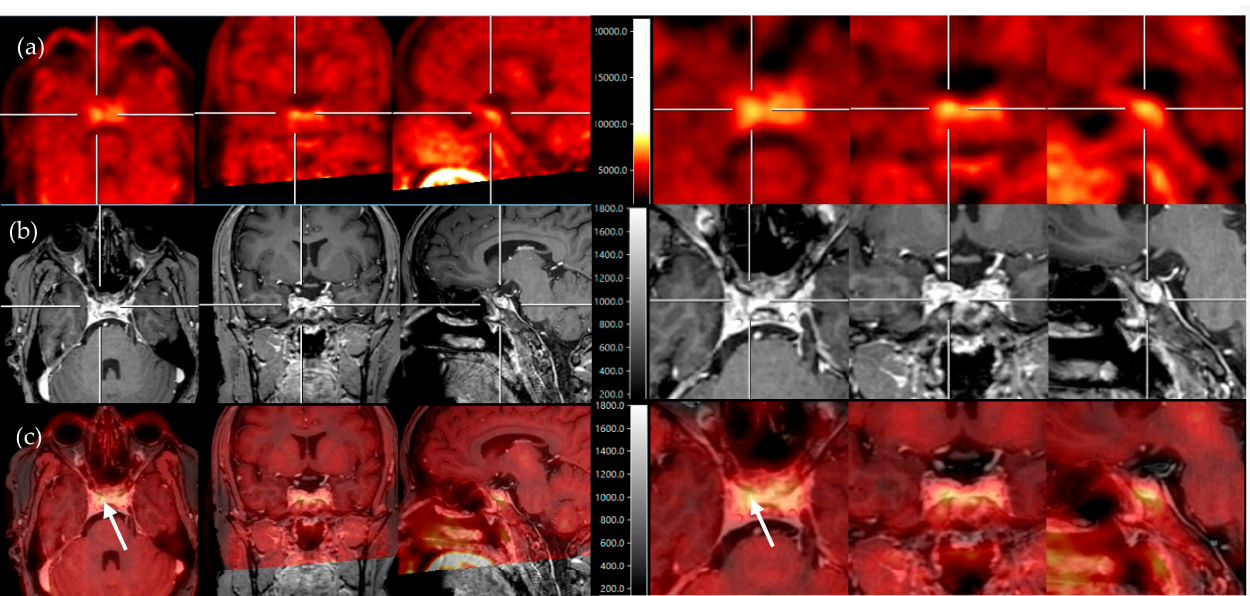
Figure 2. 18 F-FET PET and fusion of PET with post-contrast T1 MR images reveal asymmetrical focal high uptake (in yellow) lateral in the right pituitary, as centered with the crosshair ( a – c ) and shown with the white arrows ( c ). ( a ) axial, coronal, and sagittal view of PET scan after infusion of 192 MBq 18F-FET, ( b ) axial, coronal, and sagittal view of 3D T1-weighted, post-gadolinium MRI, and ( c ) axial, coronal, and sagittal view of PET/MRI fusion. Scans on the right side present the same lesion but in more detail.